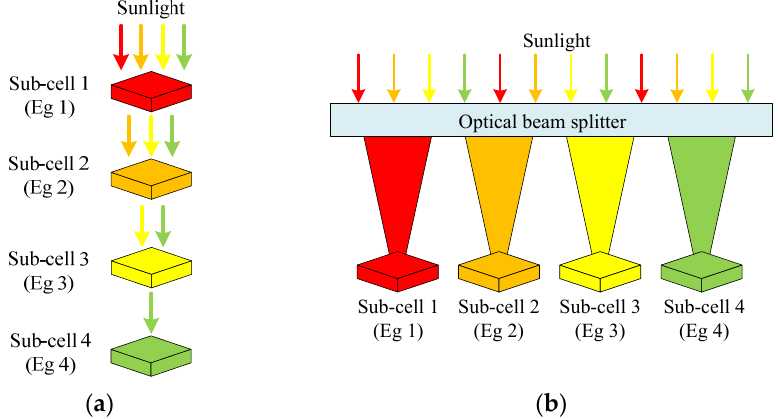
Figure 31. The architecture of the VMJ solar cell ( a ) and the LMJ solar cell ( b ). Here, the bang-gap energies are Eg1 > Eg2 > Eg3 > Eg4) [72].